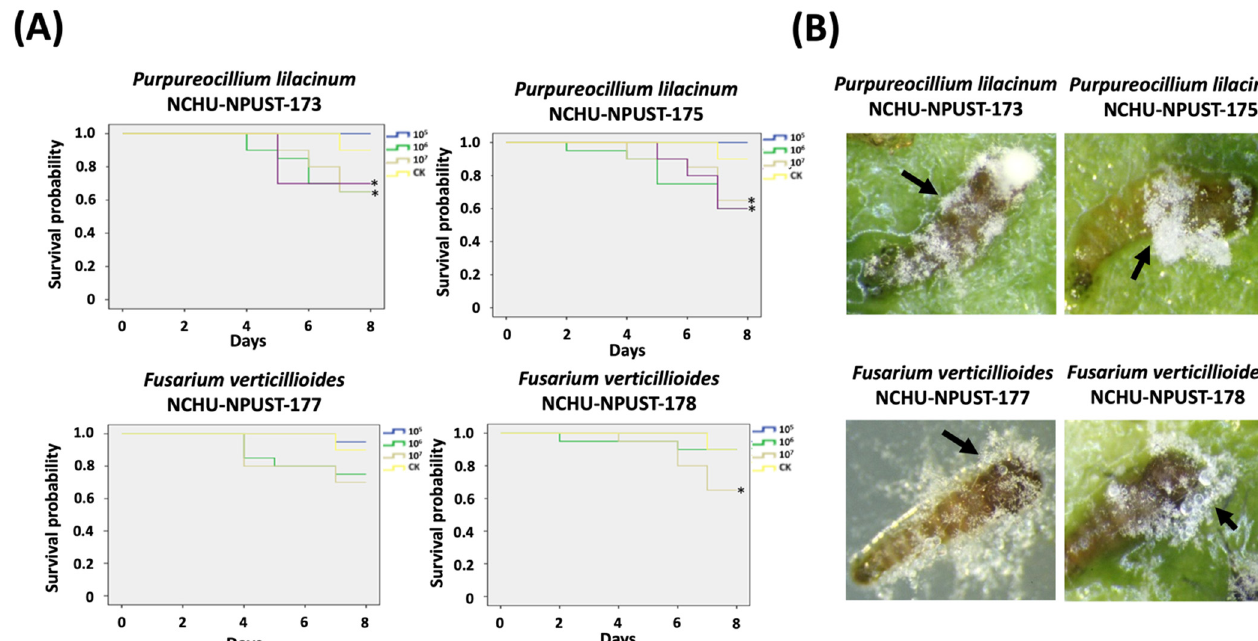
Figure 3. Virulence screening of four selected entomopathogenic fungi isolates against last instar larvae of F. taiwana . ( A ) Survival probability of last instar larvae of F. taiwana after application of P. lilacinum PL-NCHU-NPUST-175 and F. verticillioides FV-NCHU-NPUST-178 (* = significant difference based on log-rank test) and ( B ) the mycosis was observed after fungal infection.